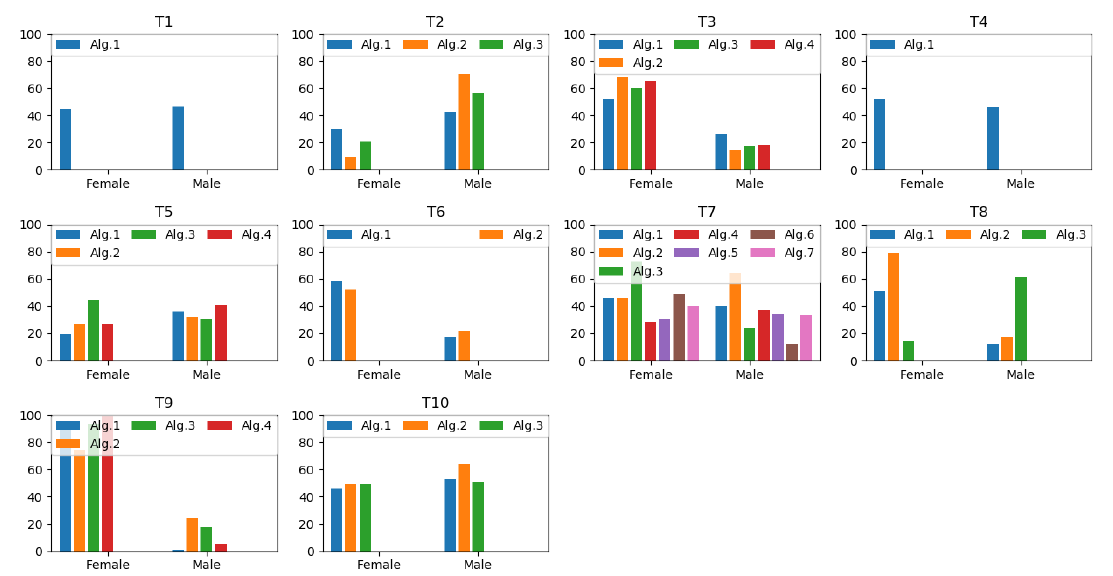
Figure 8. Gender prediction results for the 10